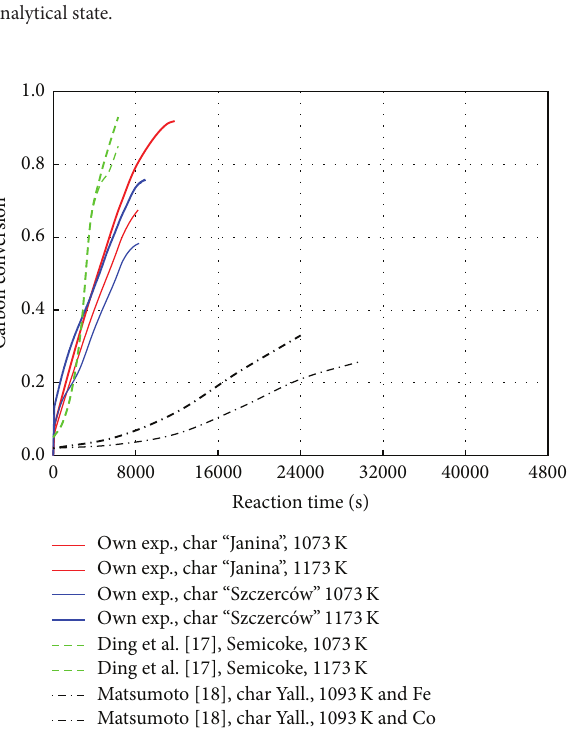
Figure 2: Influence of temperature on carbon conversion